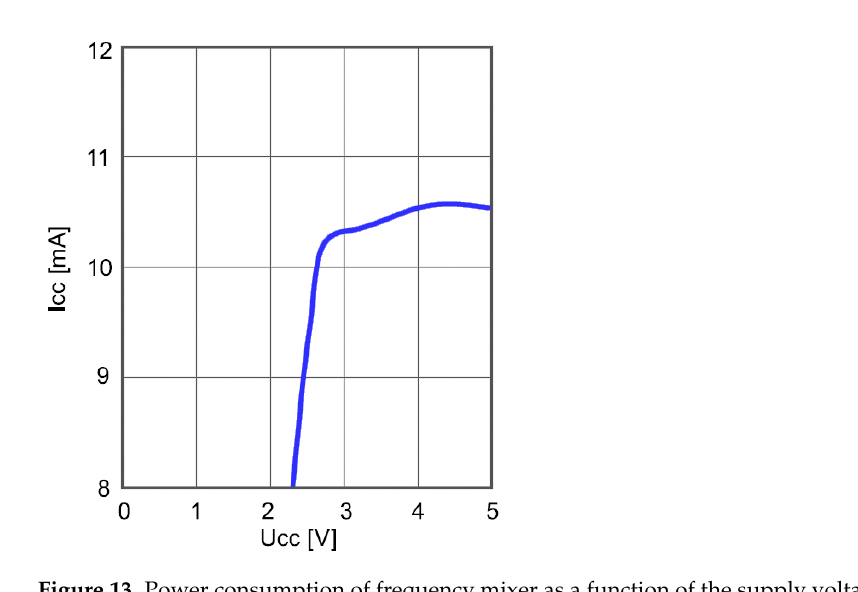
Figure 12. Power consumption of frequency divider as a function of the supply voltage.